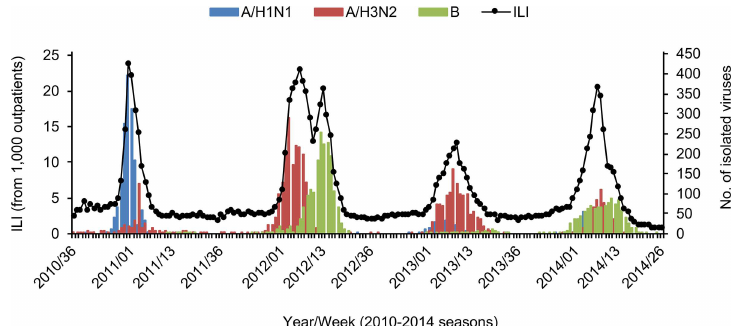
Fig 1. ILI cases and the number of isolates of seasonal influenza viruses in Korea during the 2010/11- 2013/14seasons. ILI cases per 1,000 patients and the numberof isolates of seasonalinfluenzaviruses were summarized based on the nation-wideweeklysurveillancereports of KCDC on seasonalinfluenza activity in Korea duringthe 2010/11-2013/14seasons. The weeklyILI incidencerates were indicatedwith black circles linkedwith a black solid line, and the weekly number of each viral isolates was indicatedwith different colors (for H1N1, light blue; for H3N2, light red; and for humanB, light green).